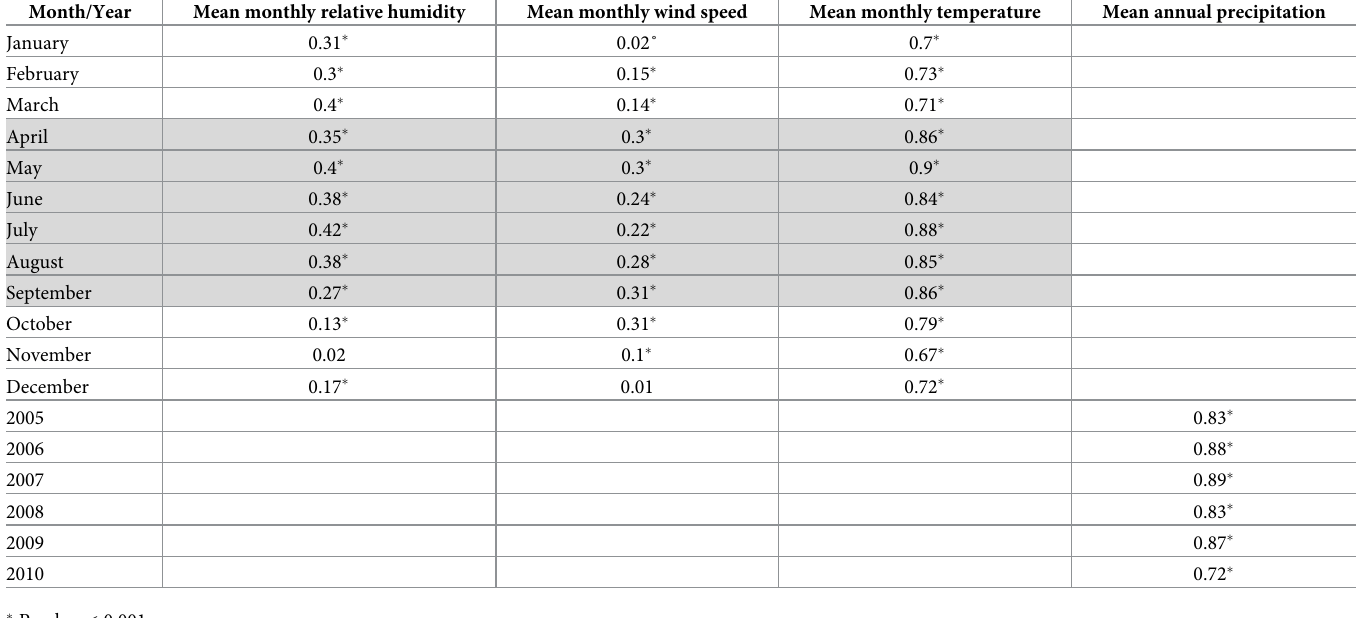
Table 8. Climate data validation results. R 2 values derived from the simple linear regression analysis between weather station climate data recordings and modelled cli- mate data using historical recordings. Overall, R 2 values were higher for the warmer months of the year